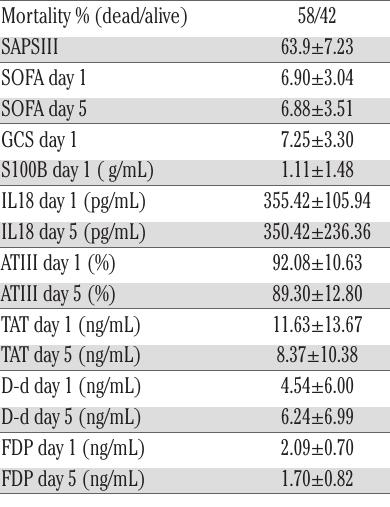
Table 4. Demographic data and severity scores.